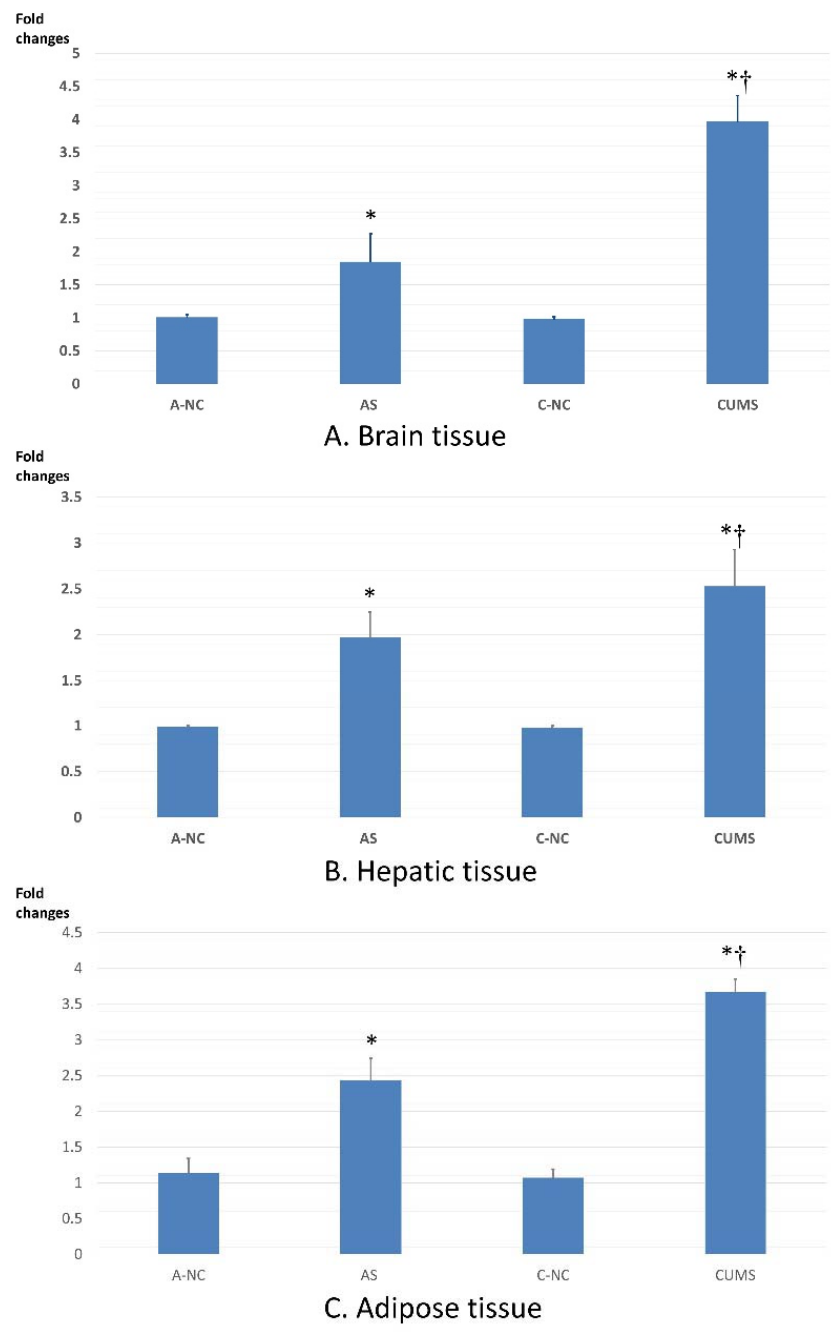
Figure 3. Fold changes in Enho gene expression in the brain ( A ), liver ( B ), and adipose tissue ( C ) of all studied groups. * represents significant differences versus the equivalent control, † denotes significant differences between CUMS and AS groups ( p < 0.05).